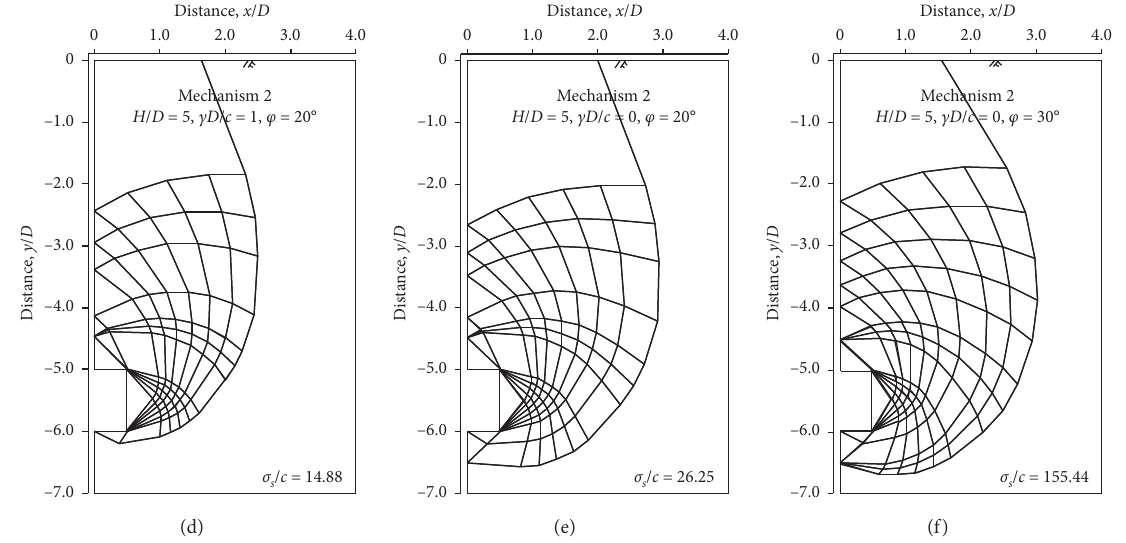
Figure 7: Failure mechanisms for square tunnels with H/D � 5. (a) c D / c � 1 and φ � 25 ° (mechanism 1). (b) c D / c � 0 and φ � 20 ° (mechanism 1). (c) c D / c � 0 and φ � 30 ° (mechanism 1). (d) c D / c � 1 and φ � 25 ° (mechanism 2). (e) c D / c � 0 and φ � 20 ° (mechanism 2). (f) c D / c � 0 and φ � 30 ° (mechanism